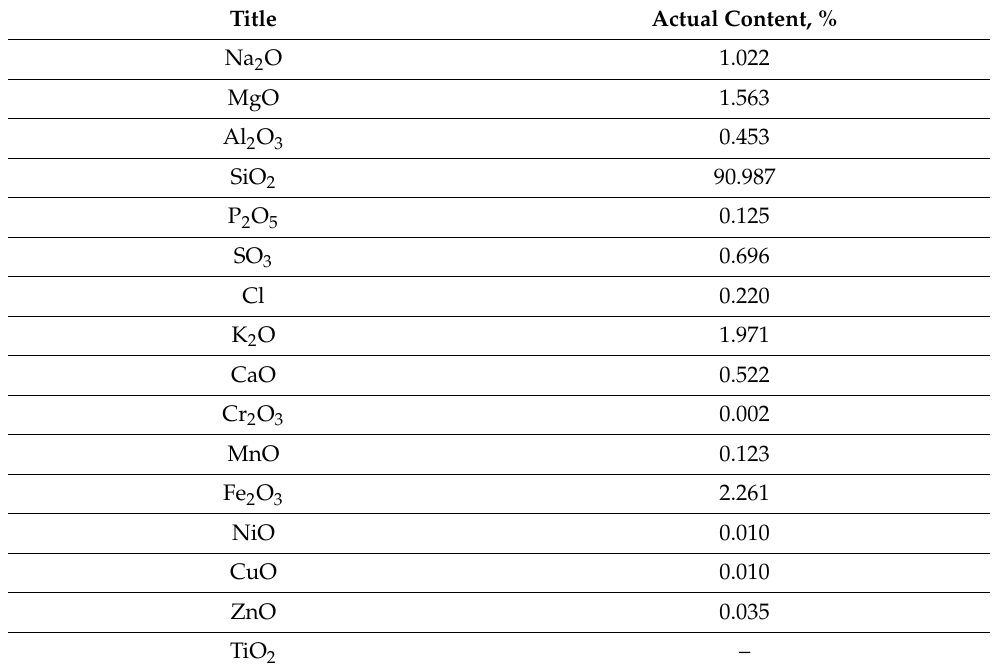
Table 4. Chemical composition of